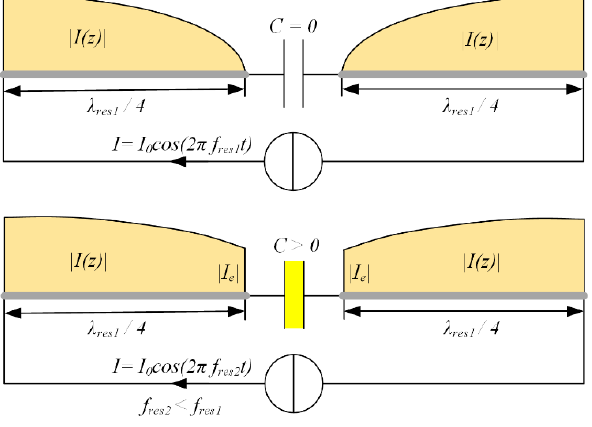
Figure 4. Current distribution in the resonator structure in reso- nance for a hypothetical split capacity C = 0 (top) and C > 0 (bot- tom).